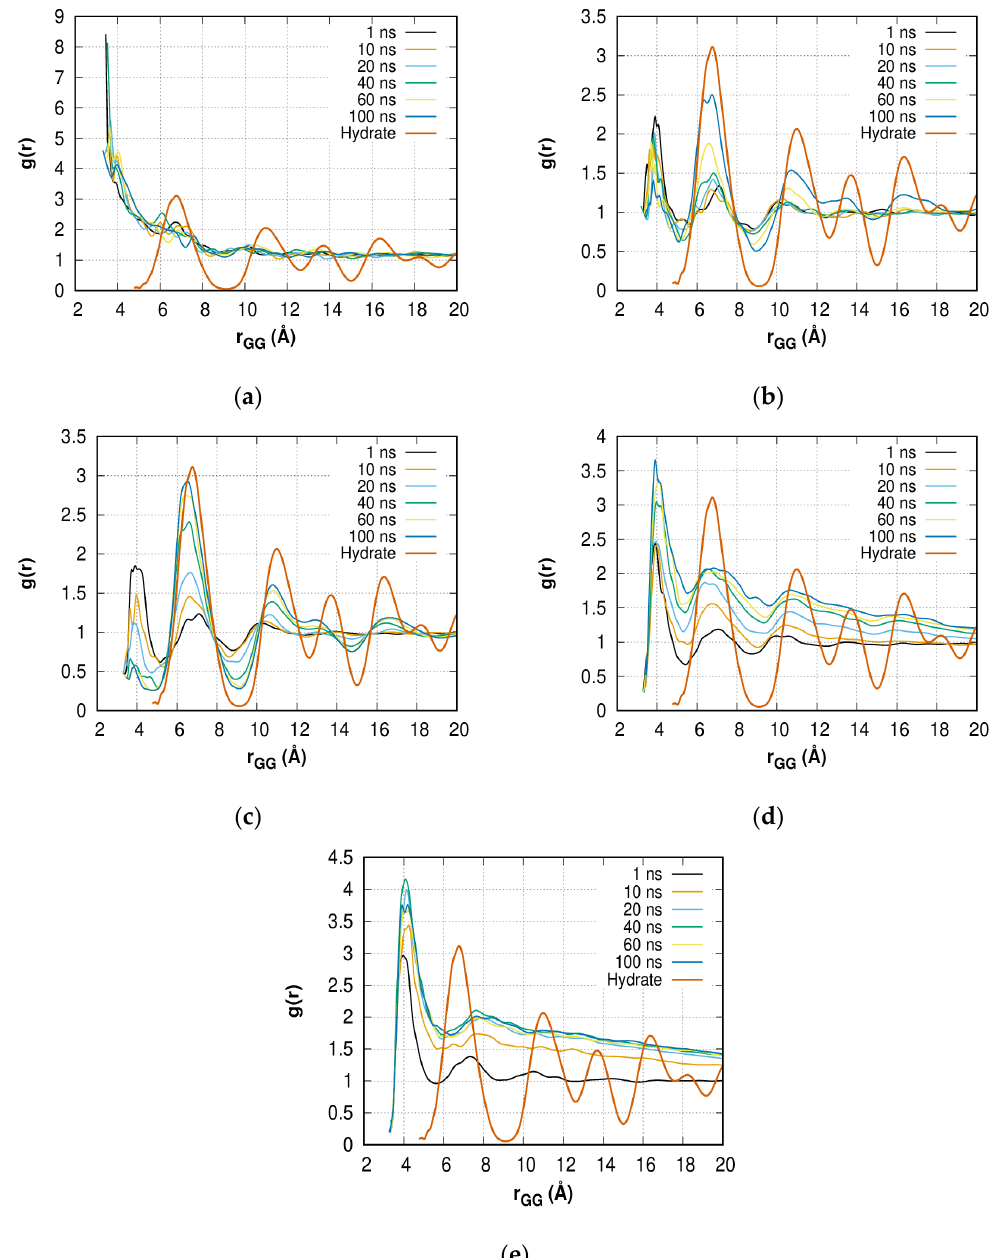
Figure 10. Gas–gas RDFs g(r) in ( a ) C = 0.2; ( b ) C = 0.4; ( c ) C = 0.6; ( d ) C = 0.8; ( e ) C = 1.0 solutions at different time points in comparison with the bulk hydrate phase. The r GG distance distribution step is 0.01 Å.